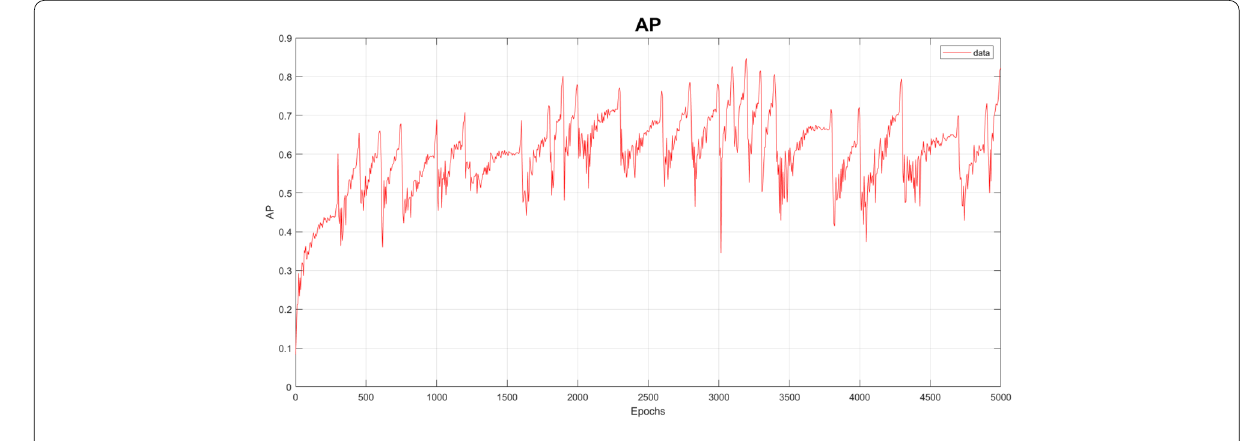
Figure 5 Change in AP with respect to Epochs